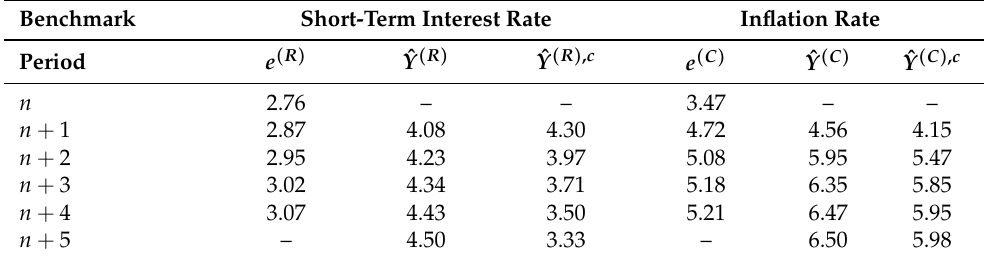
Table 8. Predicted excess stock returns from the econometric model in Section 2.4 under the short-term ( A ) interest rate benchmark or the inflation rate benchmark. e n is the last earnings-by-price observation in our records (transformed according to the benchmark A ) and corresponds to December 2019. ˆ Y ( A ) denotes the one-year predictions of excess stock returns from the linear Model (12) (parameter estimates in Table 6) and ˆ Y ( A ) , c is their corrected counterparts based on (13)–(15) (parameter estimates in Table 7). Benchmark Short-Term Interest Rate Inflation